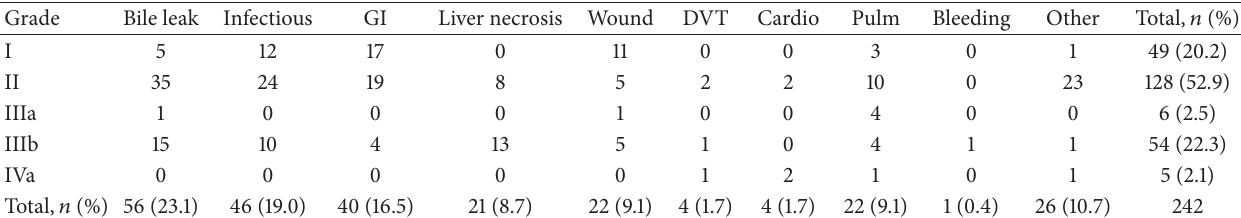
Table 2: Classification distribution of postoperative complications according to Clavien-Dindo